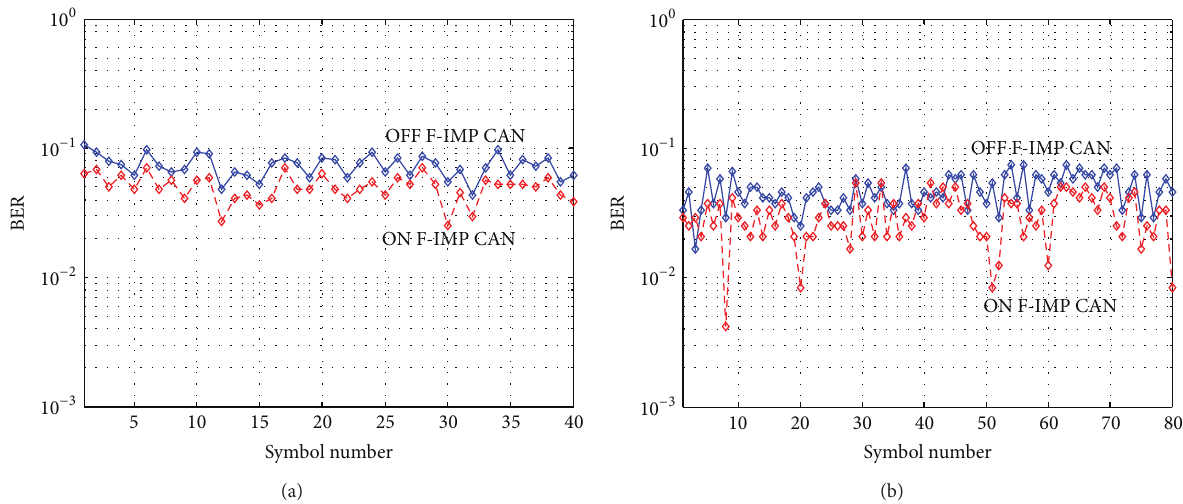
Figure 9: (a) MODE3 BER comparison for 16QAM at Okinawa. (b) MODE2 BER comparison for 16QAM at Shizuoka.